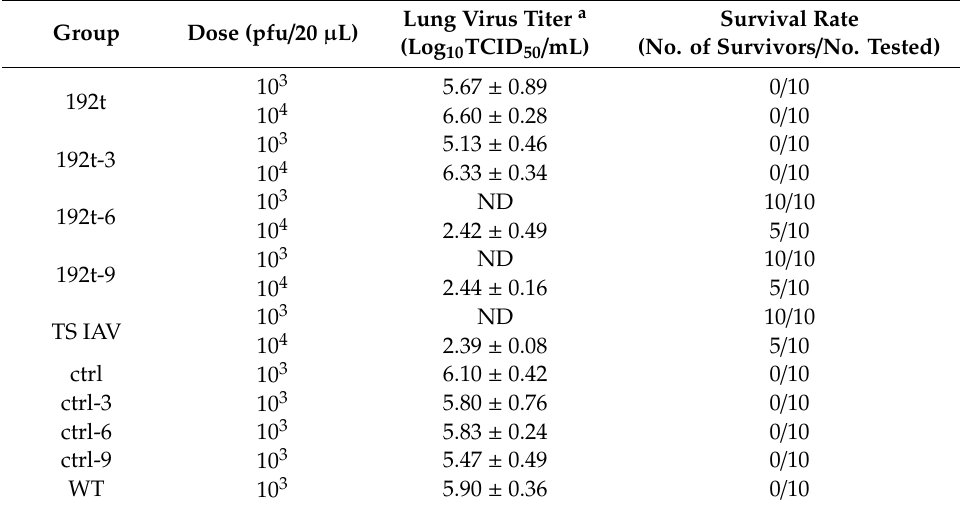
Table 1. The Lung virus titer and the mortality of mice by infection of miRNA targeted viruses. Lung Virus Titer a Survival Rate Group Dose (pfu / 20 µ L) (Log 10 TCID 50 / mL) (No. of Survivors / No. Tested) 10 3 5.67 ± 0.89 0 / 10 192t 10 4 6.60 ± 0.28 0 / 10 10 3 5.13 ± 0.46 0 / 10 192t-3 10 4 6.33 ± 0.34 0 / 10 10 3 ND 10 / 10 192t-6 10 4 2.42 ± 0.49 ND 10 / 10 192t-9 2.44 ± 0.16 10 3 ND 10 / 10 TS IAV 10 4 2.39 ± 0.08 5 / 10 ctrl 10 3 6.10 ± 0.42 0 / 10 ctrl-3 10 3 5.80 ± 0.76 0 / 10 ctrl-6 10 3 5.83 ± 0.24 ctrl-9 5.47 ± 0.49 5.90 ± 0.36 0 /